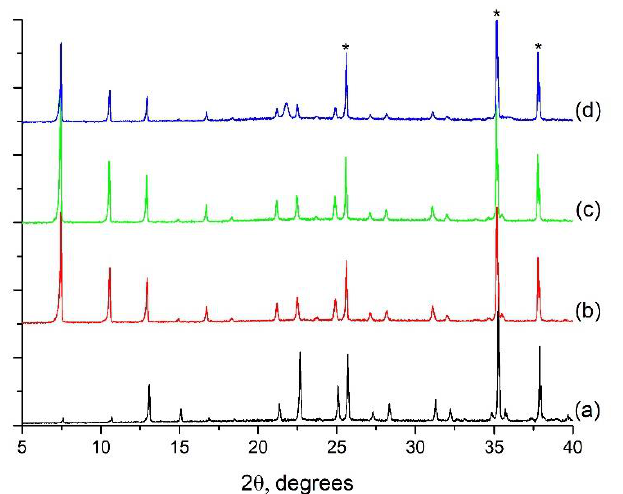
Figure 8. XRD patterns of pure silica ITQ-29 materials grown on the alumina supports: ( a ) uncalcined; ( b ) calcined at 773 K; ( c ) calcined at 823 K; ( d ) calcined at 873 K. *: alumina peaks from the support.